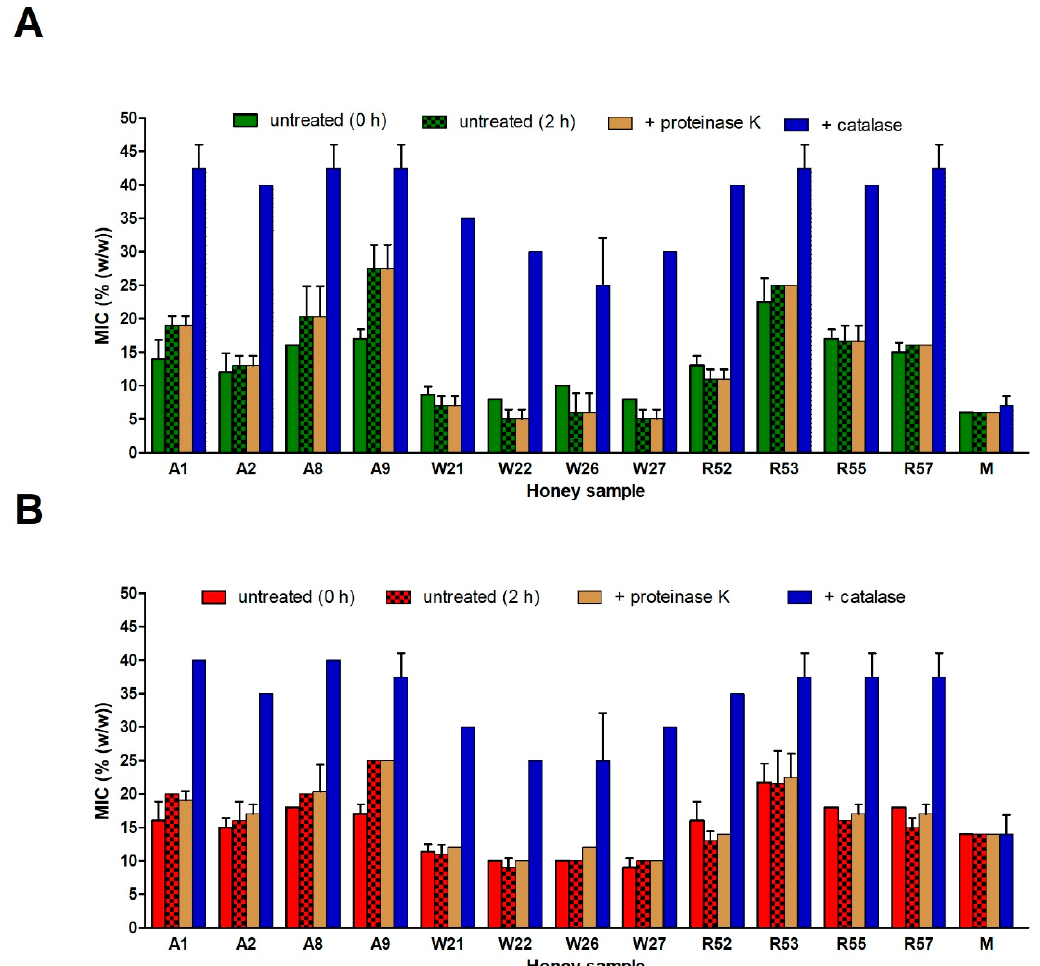
Figure 7. Antibacterial activity of selected blossom honeys ( n = 12) and medical-grade manuka honey following catalase and proteinase K treatment against ( A ) Staphylococcus aureus and ( B ) Pseudomonas aeruginosa isolates. The 50% ( w / v ) honey solutions were treated with catalase at room temperature (RT) for 2 h or with proteinase K at 37 °C for 30 min. As controls, antibacterial activity of untreated 50% ( w / w ) honey solutions are given, both not incubated (0 h) and incubated at RT for 2 h. The antibacterial activity was determined with a MIC assay. The MIC was defined as the lowest concentration of honey solution (%) inhibiting bacterial growth. M, manuka honey. The data are expressed as the mean values with standard deviation (SD).